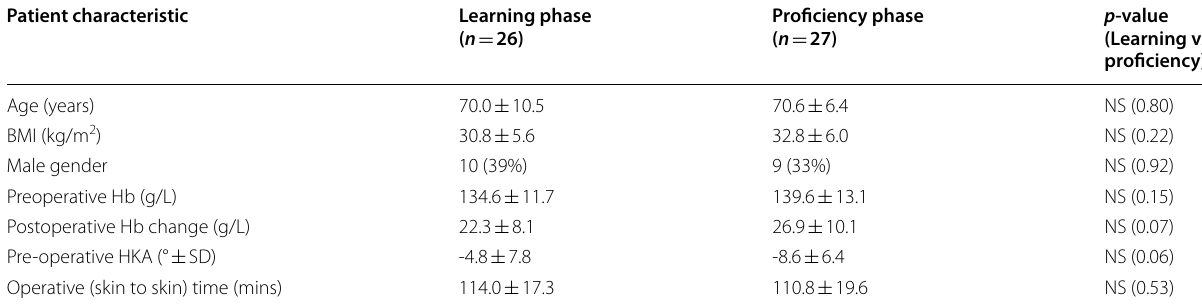
Table 2 Comparison of patient demographics within the learning curve phases of ROSA TKA